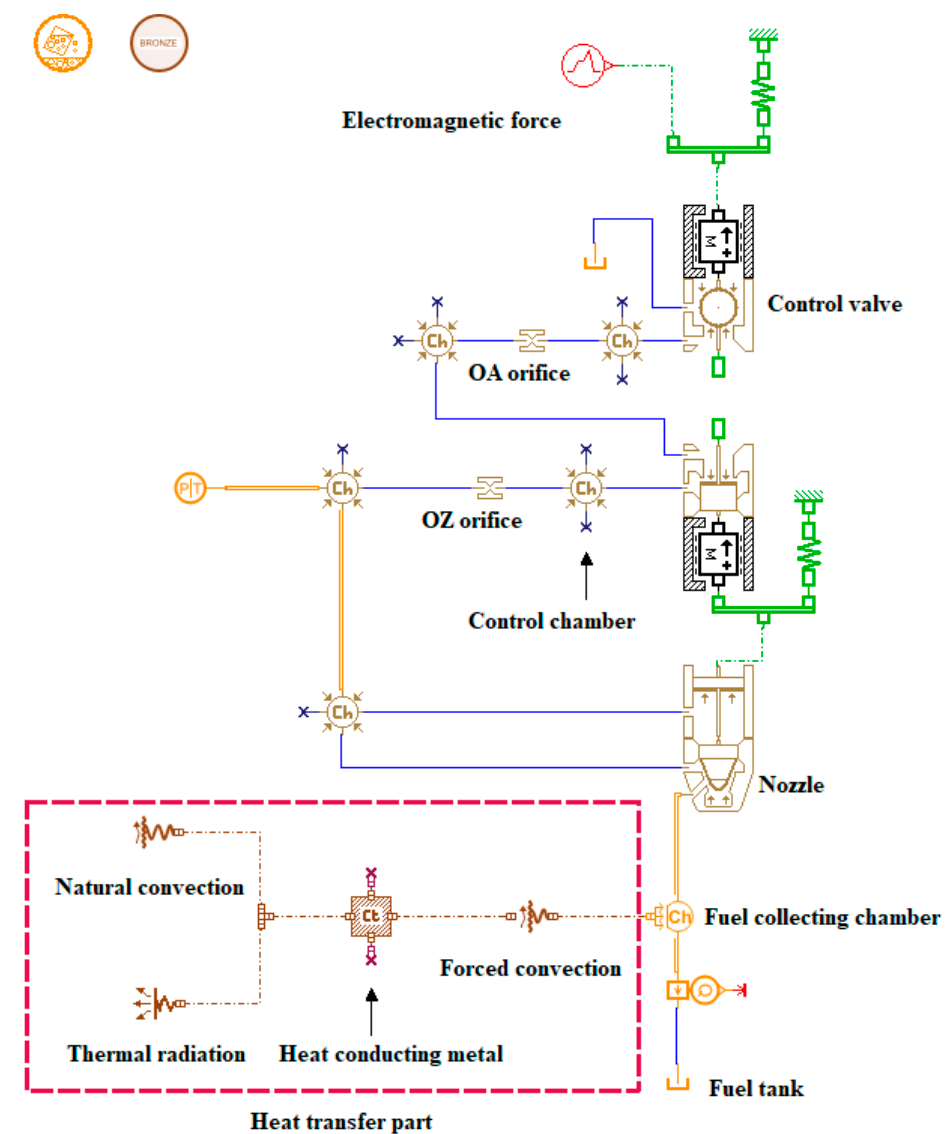
Figure 9. The simulation model of the CR injector under non-isothermal flow coupled with heat transfer process.